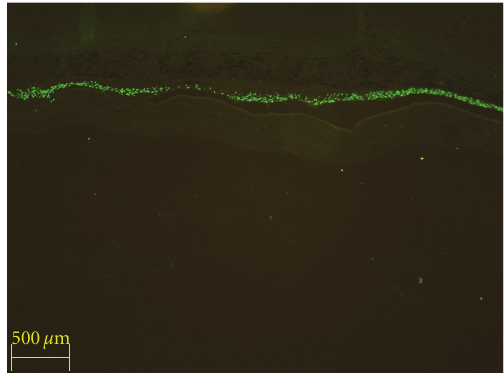
Figure 1: Identification of donor cells, graft placement, and survival at 10 days. Donor cells were identified via anti-human nuclear immunolabeling and an FITC-conjugated secondary anti- body. Abundant human nuclear profiles (green) extend in a line horizontally across the image, the location of which is the subretinal space, corresponding precisely to the initial site of deposition. In this particular view, there is no evidence of migration or integration of donor cells into host tissues. The retina, seen here as the faintly striated, unlabelled tissue directly beneath the grafted cells, appears detached from the overlying structures; however, this was not seen in vivo and is an artifact of the method of histological processing